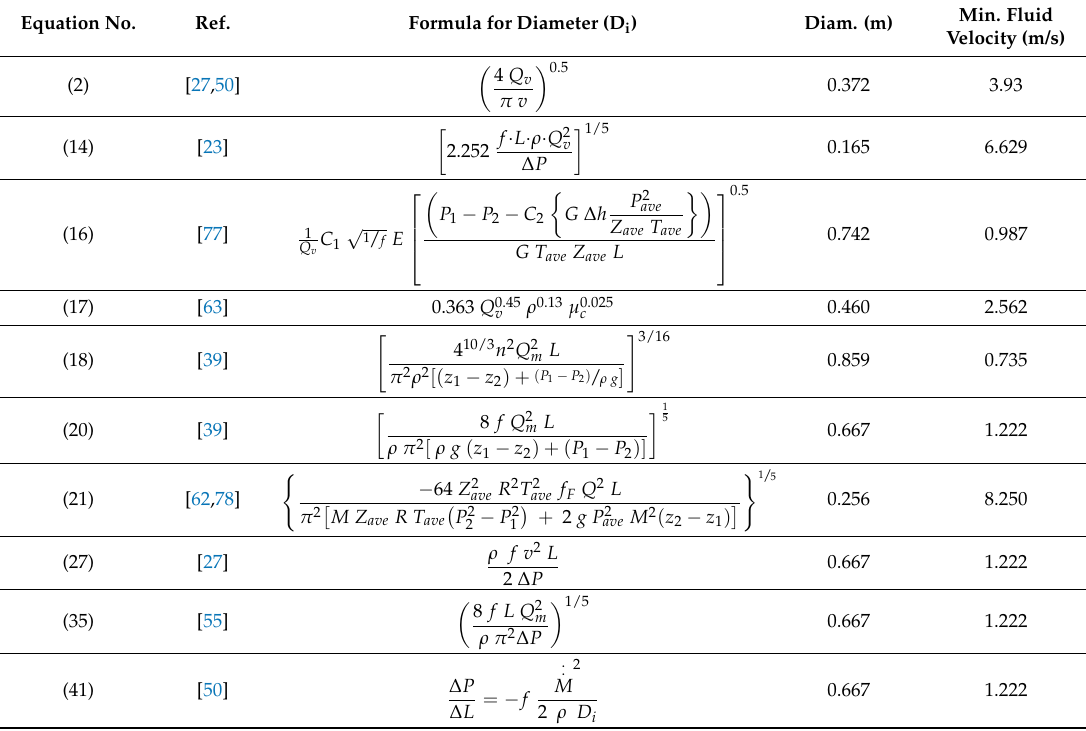
Table 6. Diameter prediction for 200 km pipeline with model formulae and resultant fluid velocity. Equation